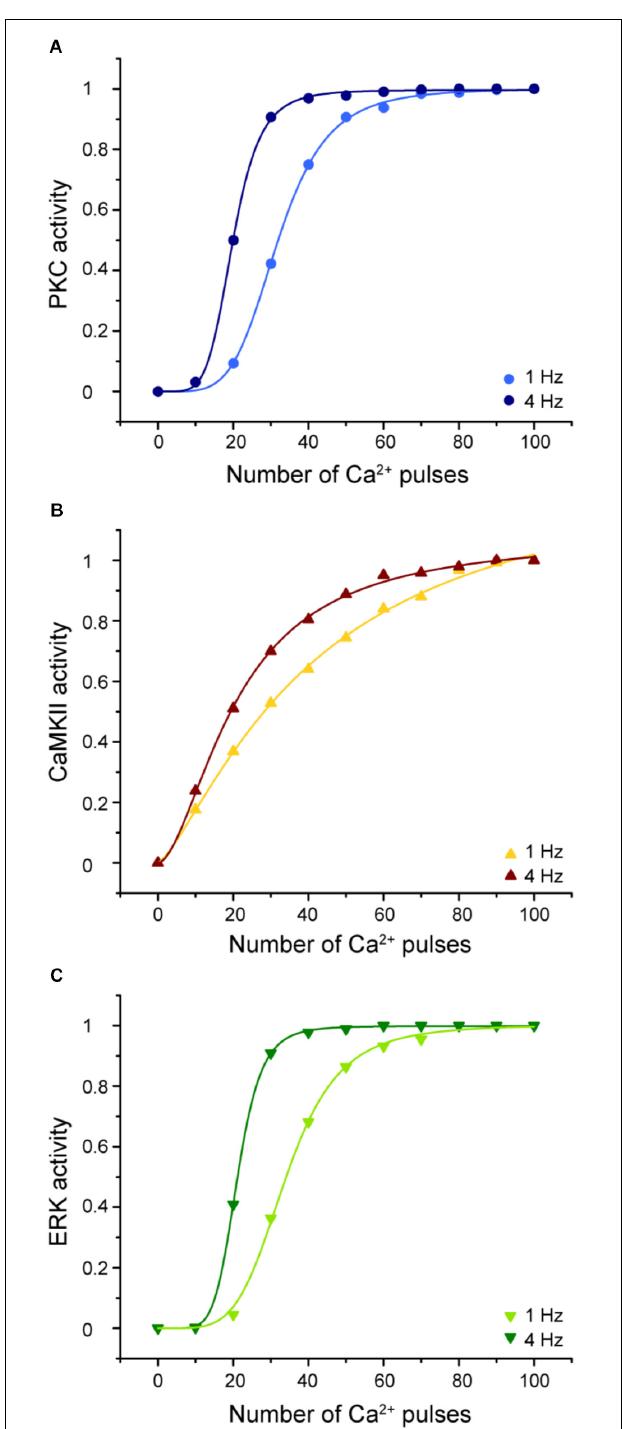
FIGURE 9 | Enzymatic activity in the LTD signaling network is sensitive to the frequency and number of Ca 2 + pulses. Sigmoidal relationship between the normalized activity of PKC, CaMKII, and ERK with number of calcium pulses at 1 and 4 Hz. (A) PKC, (B) CaMKII, and (C) ERK activity. Every symbol (dots for PKC, triangles for CaMKII and inverted triangles for ERK) represents the mean of 100 trials of enzyme activity at equilibrium state at 30 min after the calcium stimulus